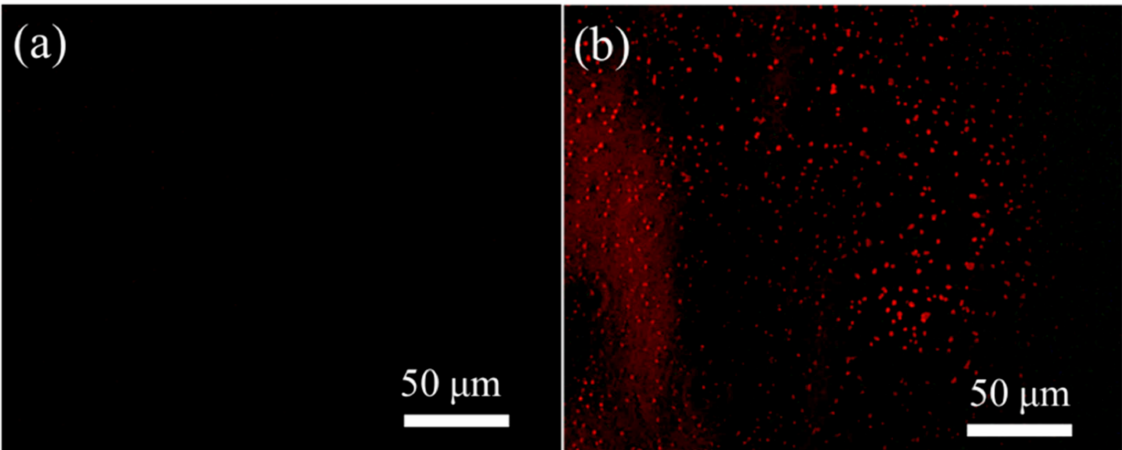
Figure 4. Fluorescence microscopy images of B. subtilis before ( a ) and after PA-AEW treatment ( b